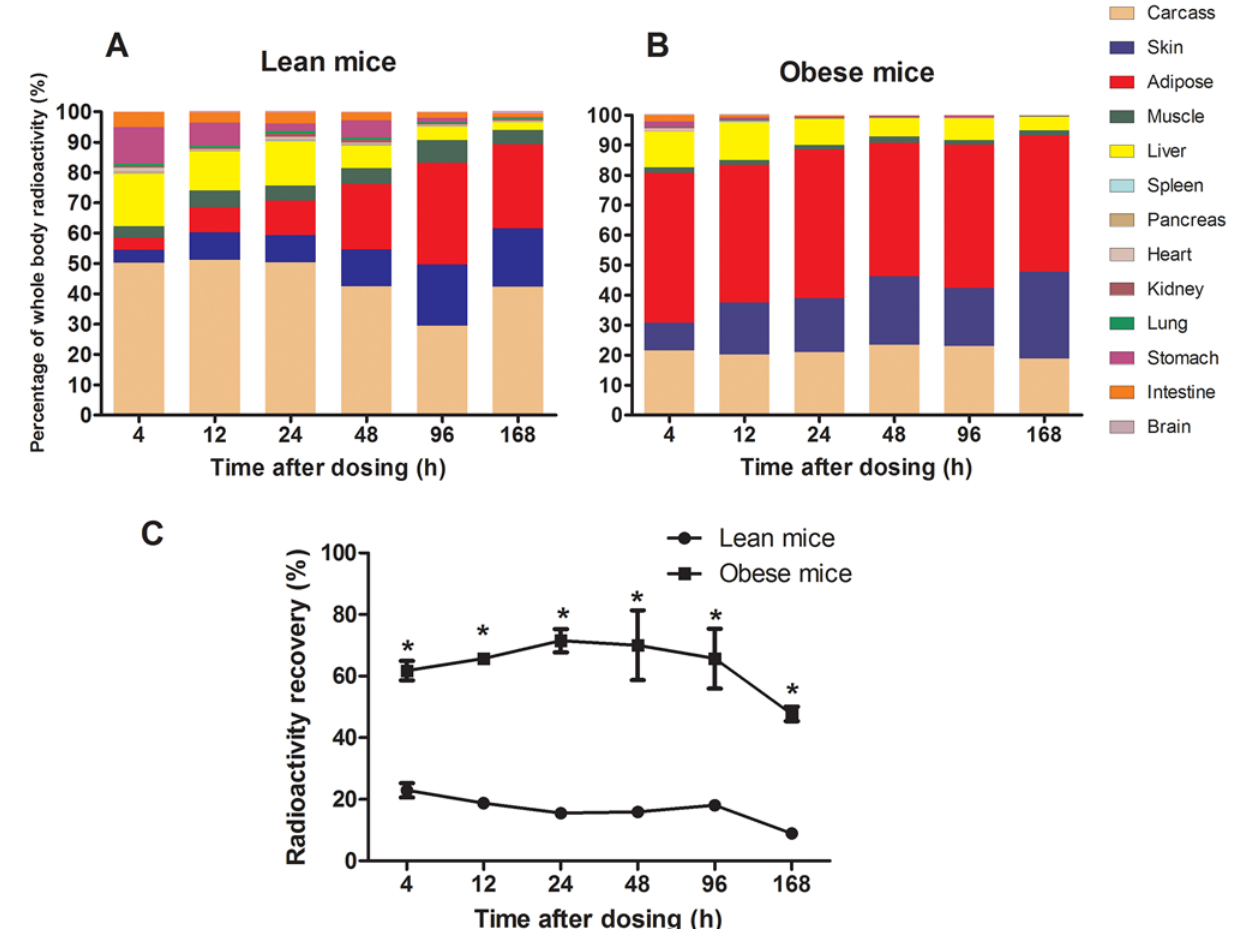
Fig 1. Whole body distribution (%) of 14 C-label in various organs/tissues from lean mice (A) and obese mice (B). The mean recovery (%) of the oral dose of 14 C-label at various time points in the whole body of lean and obese mice (C). The total amount of 14 C-label per organ/tissue was calculated based on the concentration data and the total organ/tissue weight. The total 14 C-label contents in the tissues and carcasses were summed to calculate the whole body total content and the recovery. The data for each organ/tissue are presented as a percentage of the whole body total radioactivity at each time point, and the values are presented as the mean ± SEM (n = 3). Asterisks ( * ) indicate significant differences between lean and obese mice at a particular time point ( P <